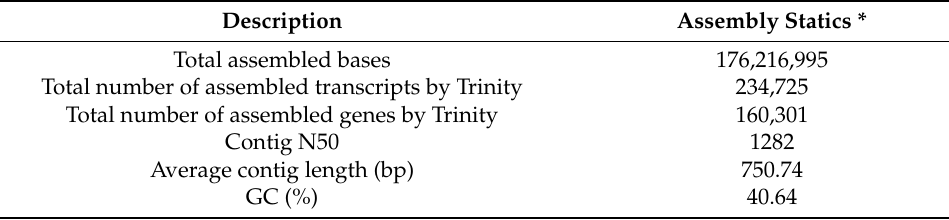
Table 2. De novo transcriptome assembly statistics of upper leaves and roots in a tipburn damaged cultivar and a cultivar where tipburn did not